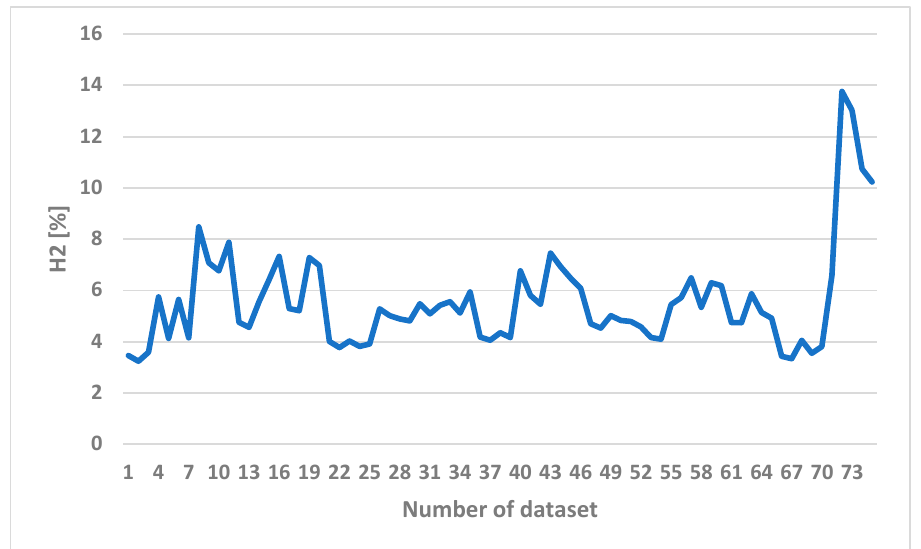
Figure 7. The H 2 content of syngas in different operating conditions.